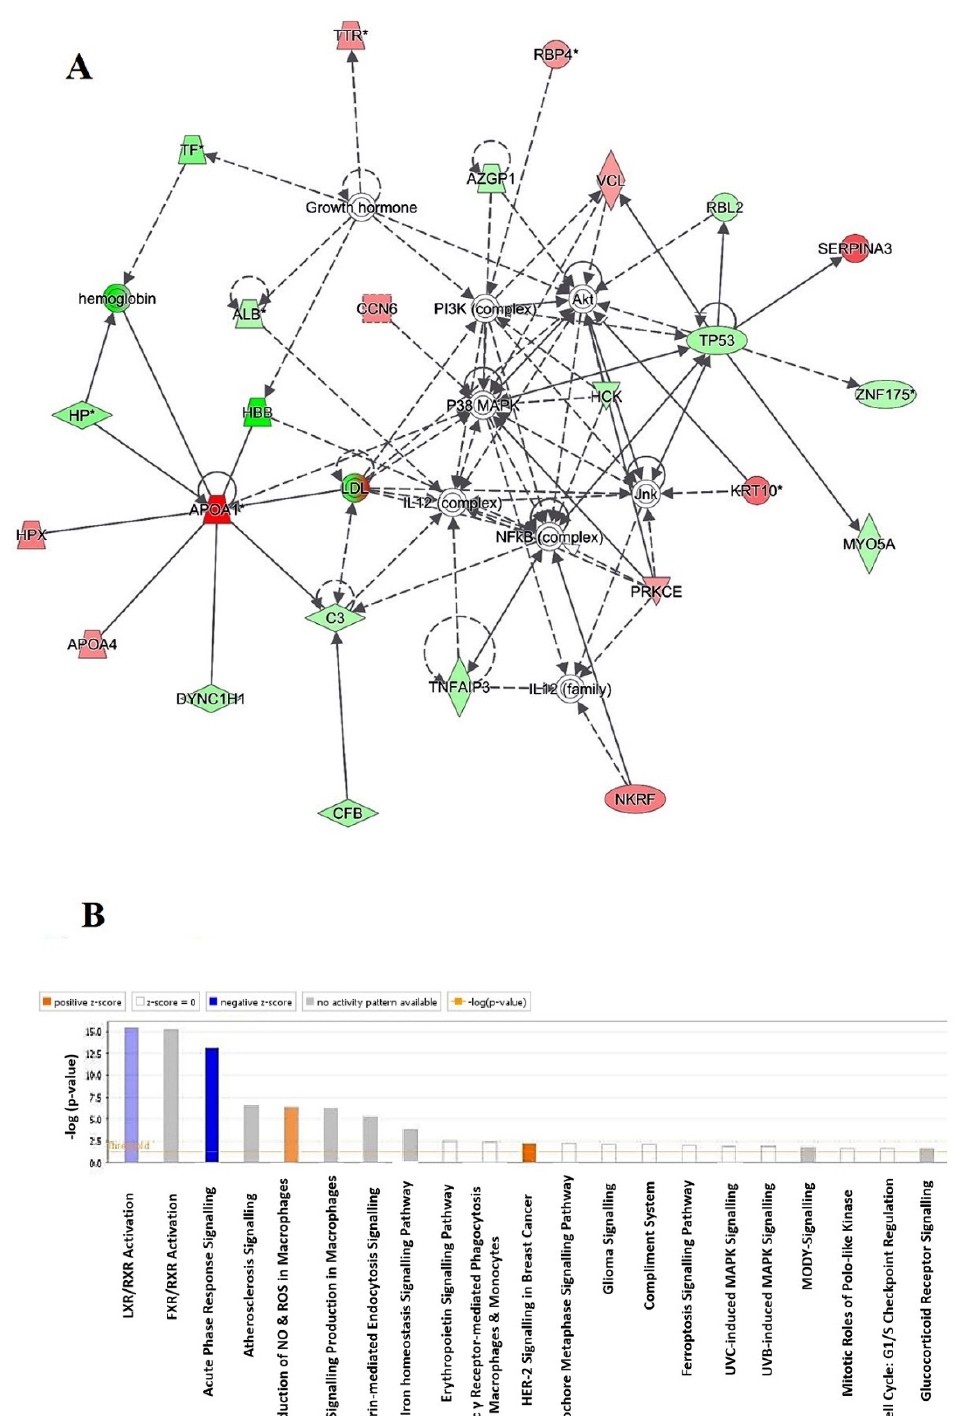
Figure 5. The most enriched interaction network of the differentially expressed proteins in control group as compared with the CUD group. Red nodes indicate upregulated; green nodes indicate downregulated. The central nodes of the pathway are involved in the signaling of the P38 MAPK, NFkB (complex), and Akt, and found to be deregulated between the two groups. Nodes that are not colored are analyzed by IPA and indicate potential targets that were functionally matched with the differentially expressed proteins. Direct molecular interactions are highlighted with solid lines, while indirect interactions are highlighted with dashed lines ( A ). The diagram shows the 21 top canonical pathways ranked by the p -values obtained by the IPA ( B ).